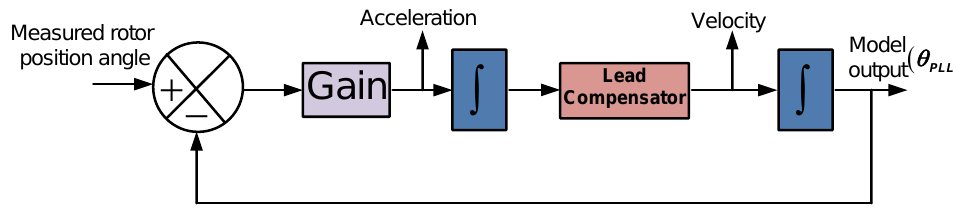
Figure 3. Observer for Speed and acceleration.